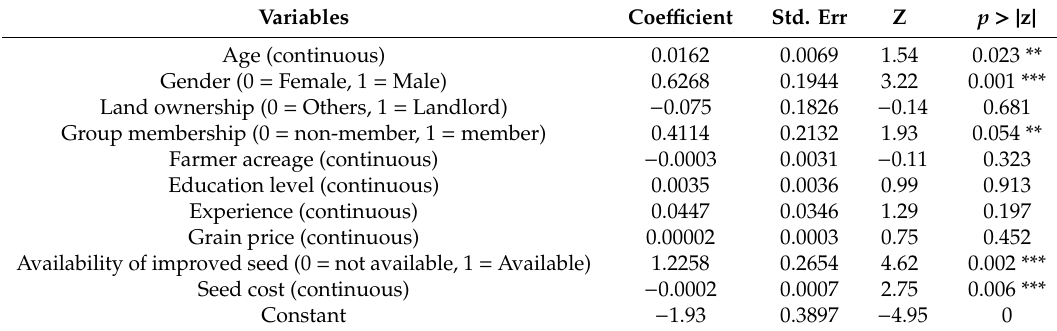
Table 8. Probit regression result of determinants of adoption of improved varieties.